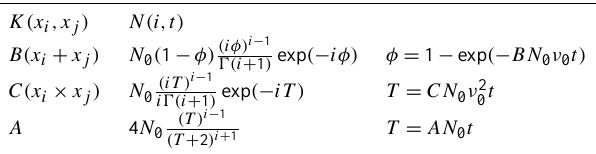
Figure 9. Time evolution of the correlation coefficients ρ 1 , 3 and ρ 1 , 5 for a 1cm 3 system modeled with the turbulent hydrodynamic kernel and containing initially 20 droplets of 14µm and 10 droplets of 17µm. Table 2. Analytical size distributions of the kinetic collection equa- tion (KCE) calculated with monodisperse initial